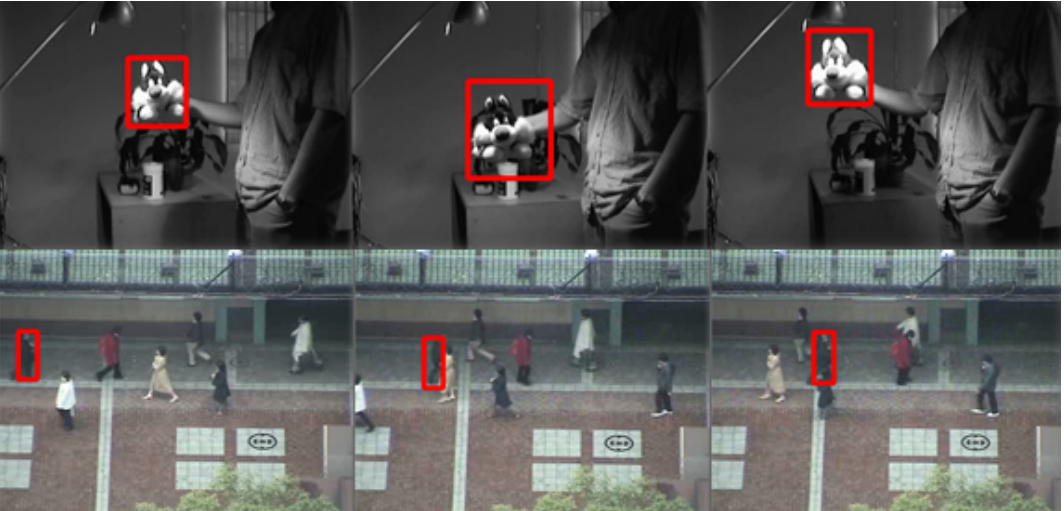
Figure 13. Two challenging video sequences in OTB-2015 involving blurry video conditions. From top to bottom, the pictures are Sylvester and Sunway, while the attributes are IV and BC. In these two scenarios, the environment in which the target is located has a great impact on the judgment of its appearance semantics. Despite this the tracker has good tracking and recognition effect, and there is no significant drift or tracking failure.